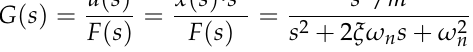
Figure 4. Fitting frequency characteristic curve of a resonance mechanism. The form of Equation (4) conforms to that of Equation (3), which verifies that the gain mode of the mechanical structure conforms to the expected model. At the resonance mech- anism’s natural frequency, the resonance mechanism’s magnification is